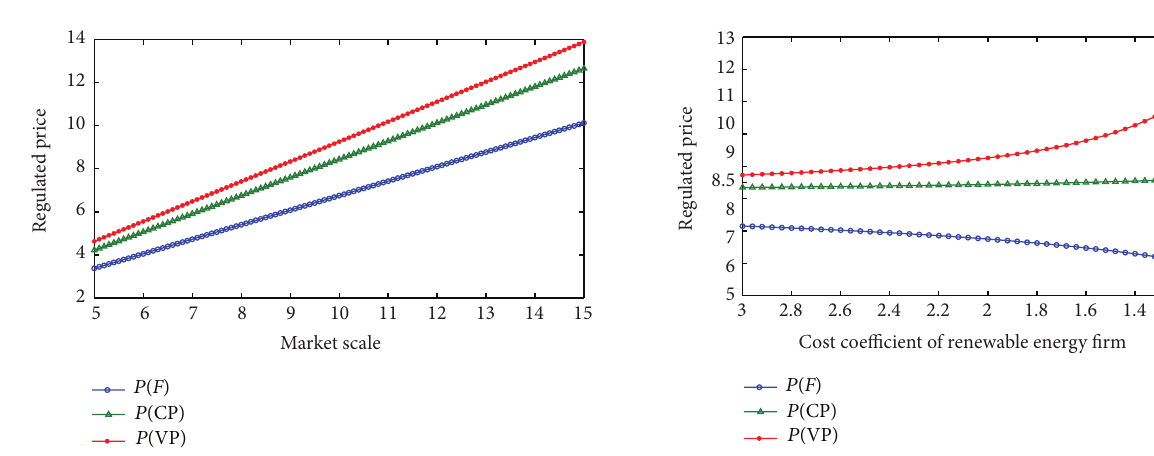
Figure 4: Three tools comparison of regulated price under the change of market scale 𝛼 .